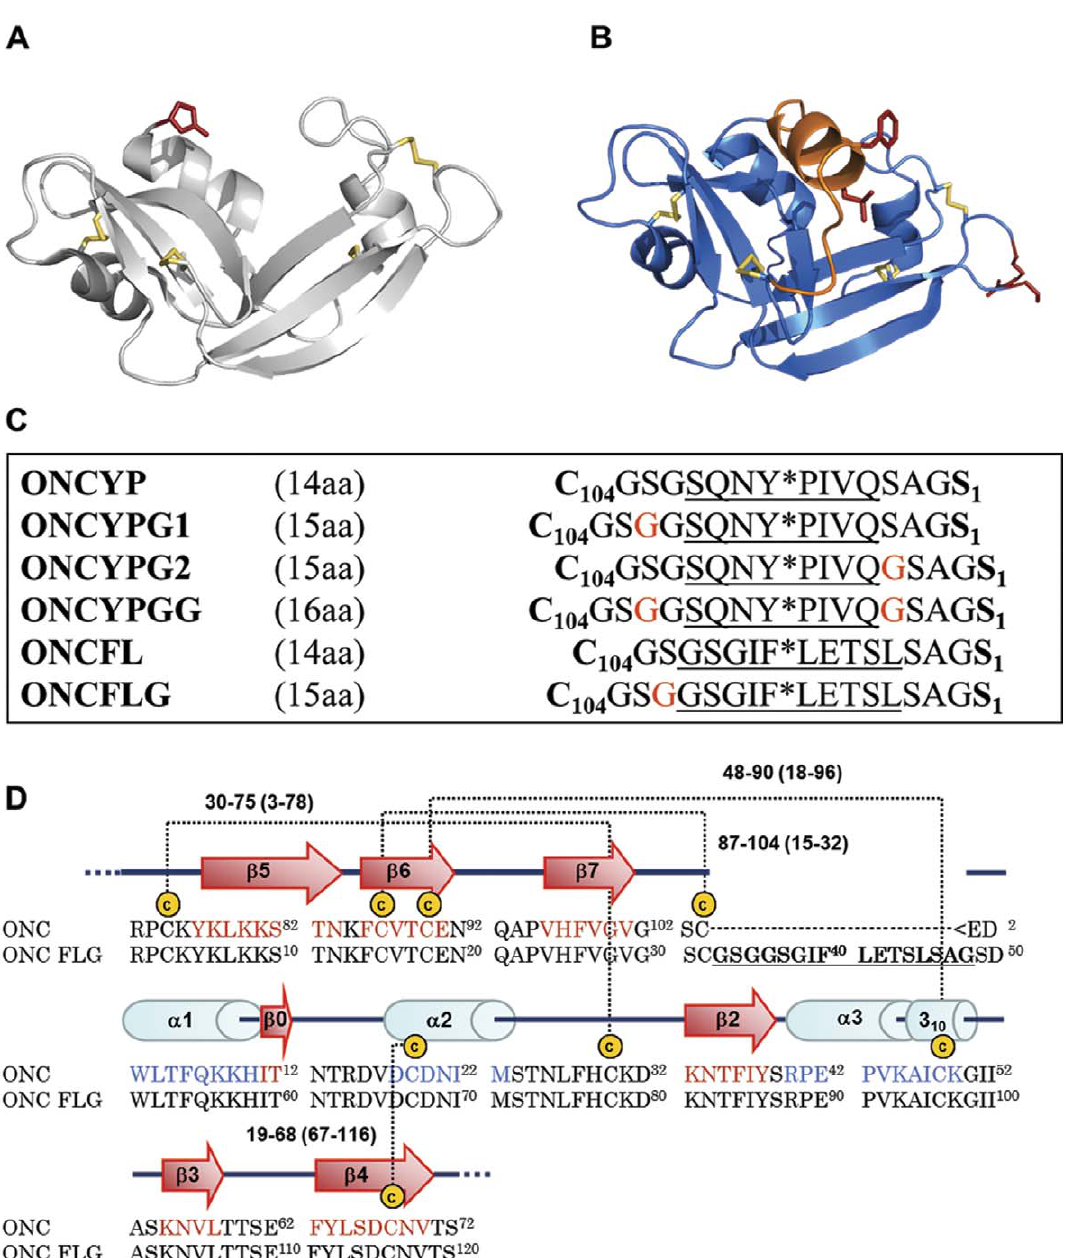
Figure 1. Zymogen model and linker sequences. (A) 3D structure of ONC (pdb accession code, 1ONC). (B) Structural model of the ONCFL variant generated using the automated homology modeling server SWISS-MODEL and energy minimized with the GROMOS 96 implementation of Swiss-PdbViewer [21]. The amino and carboxyl termini created by circular permutation and the residues that constitute the cleavage site are represented using red sticks. Both figures were drawn with PyMOL (http://pymol.sourceforge.net/). Note that the linker segment was predicted to be helical in this model, but its structural characterization by NMR shows that it is disordered. (C) Scheme of the primary sequence of the linkers used in the design and construction of the different zymogens. Native carboxyl and amino residues of ONC are in bold and Gly residues used to elongate the linker are in red. The HIV-1 protease recognition sequence is underlined and Y*P and F*L indicate the hydrolyzed peptide bonds. (D) Alignment of ONC and ONCFLG amino acid sequences showing the secondary structure representation for ONC. The residues that compose the FLG linker connecting Ser1 and Cys104 are in bold and underlined.